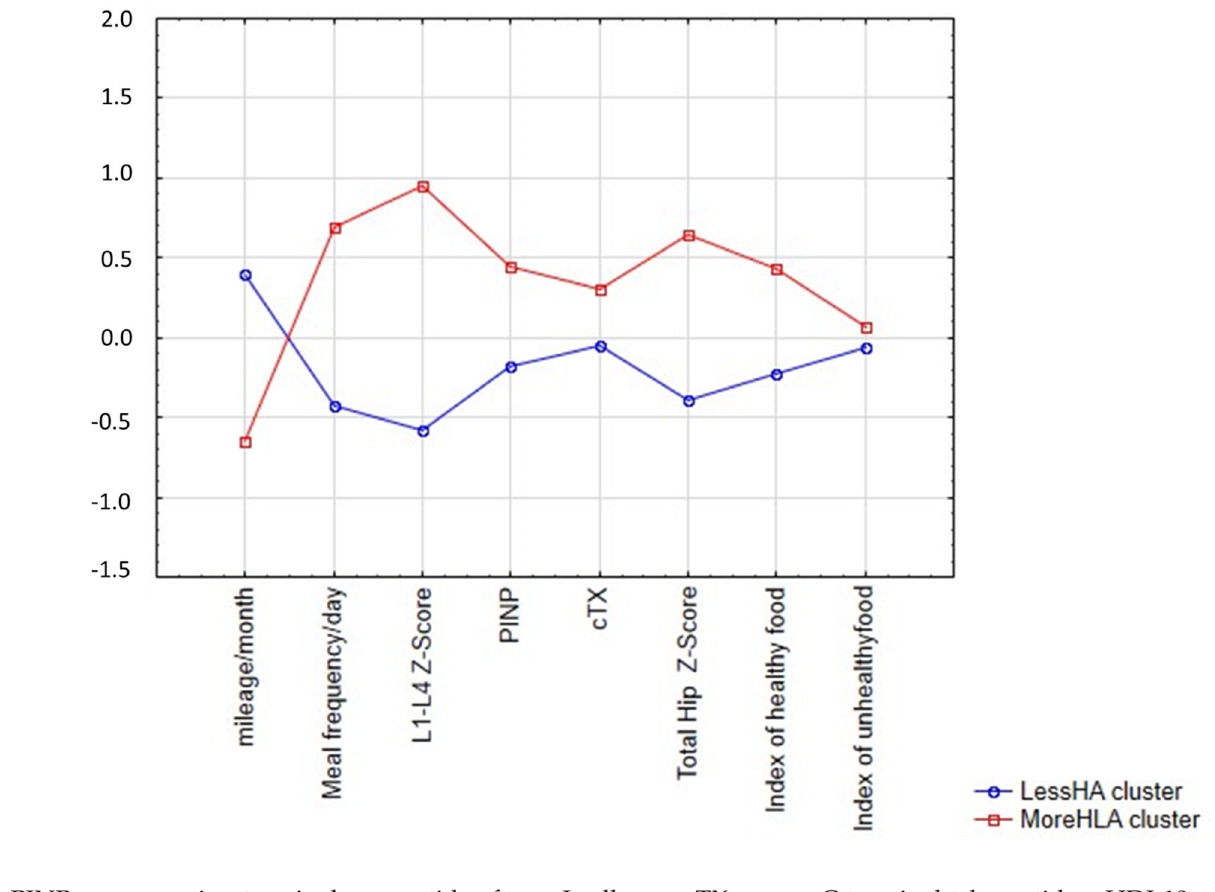
Figure 2. Mean plot of two clusters of male amateur marathoners.